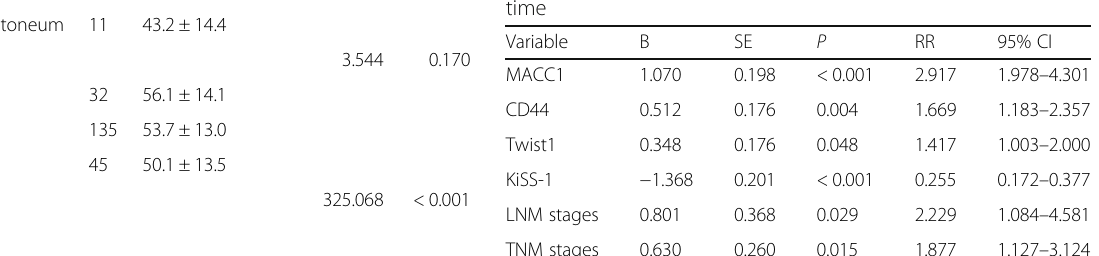
Table 6 Results of multivariate analyses of overall survival